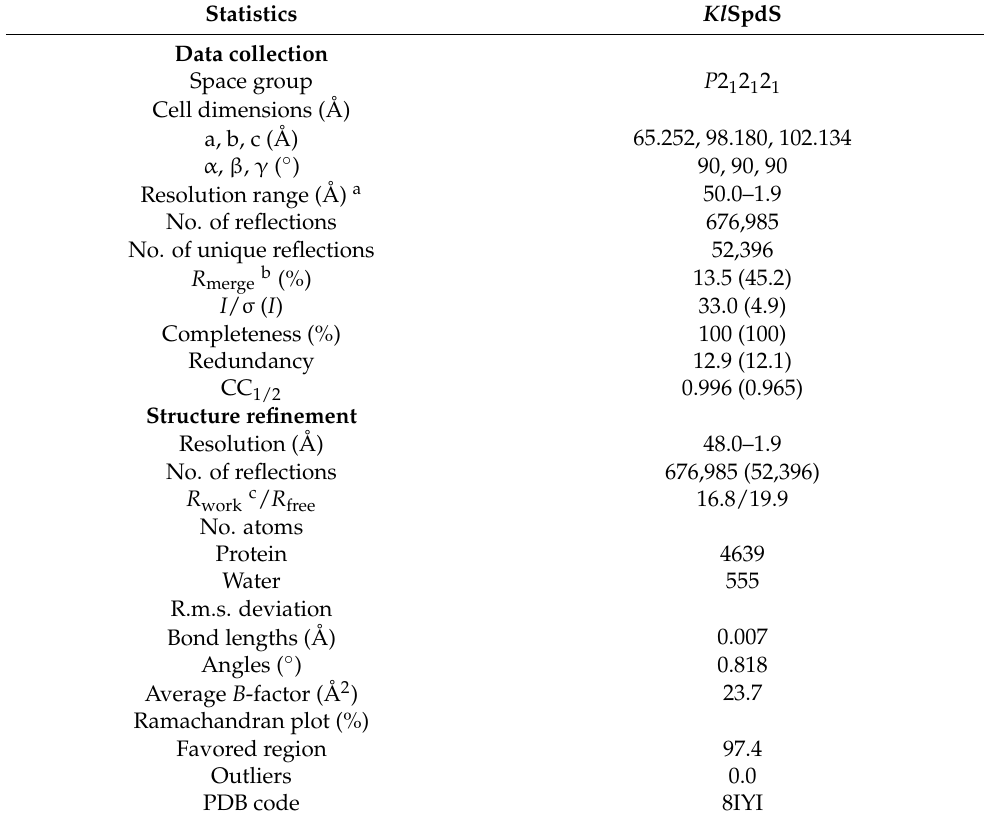
Table 2. Data collection and refinement statics for Kl